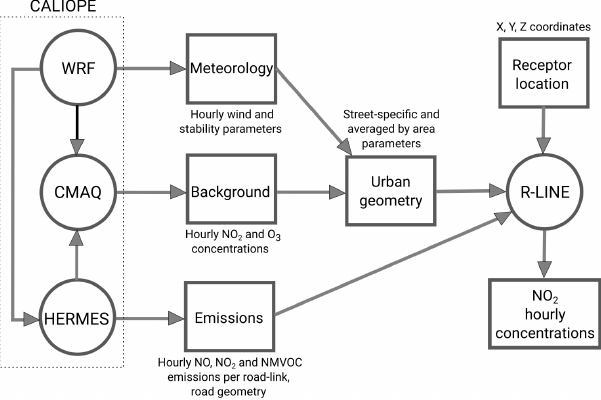
Figure 1. CALIOPE-Urban workflow. Models are represented by circles and data by rectangular shapes. CALIOPE is left untouched. Meteorology and background from WRF and CMAQ are combined with urban geometry to create inputs for R-LINE. R-LINE dis- persion is left untouched, after adjusting meteorology and surface roughness for local urban